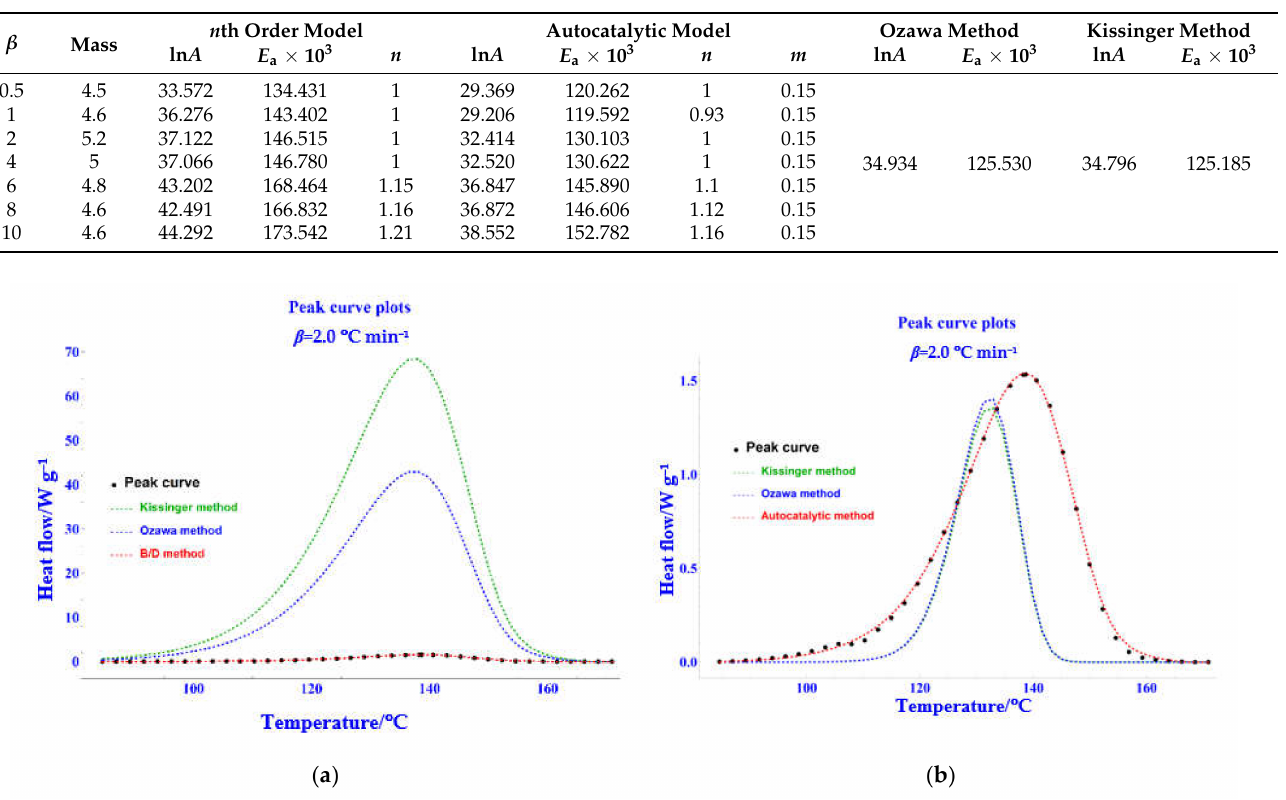
Table 8. Derived kinetic parameters comparison.